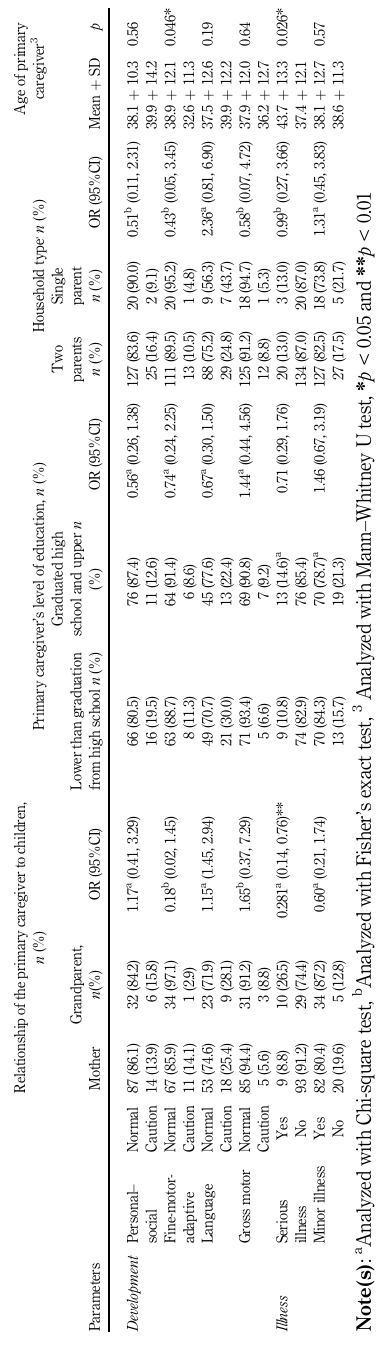
Table 4. Factors related